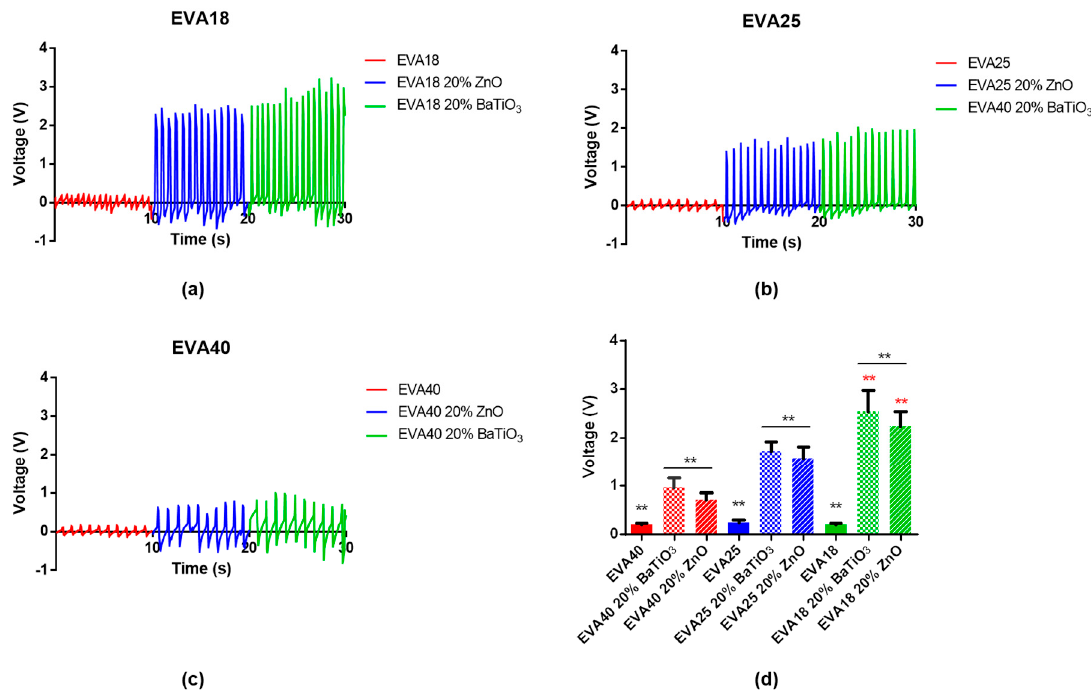
Figure 9. Electromechanical response of nanocomposite ethylene vinyl acetate (EVA) matrices: ( a ) EVA18, ( b ) EVA25, and ( c ) EVA40. ( d ) Summary of the output voltage (** = p < 0.01).